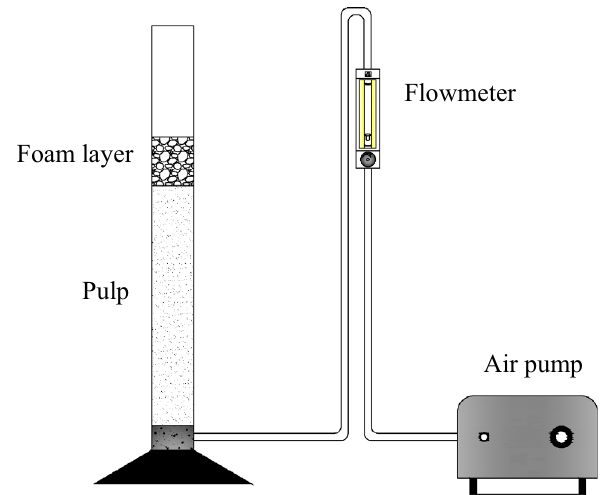
Fig. 4 Testing equipment for